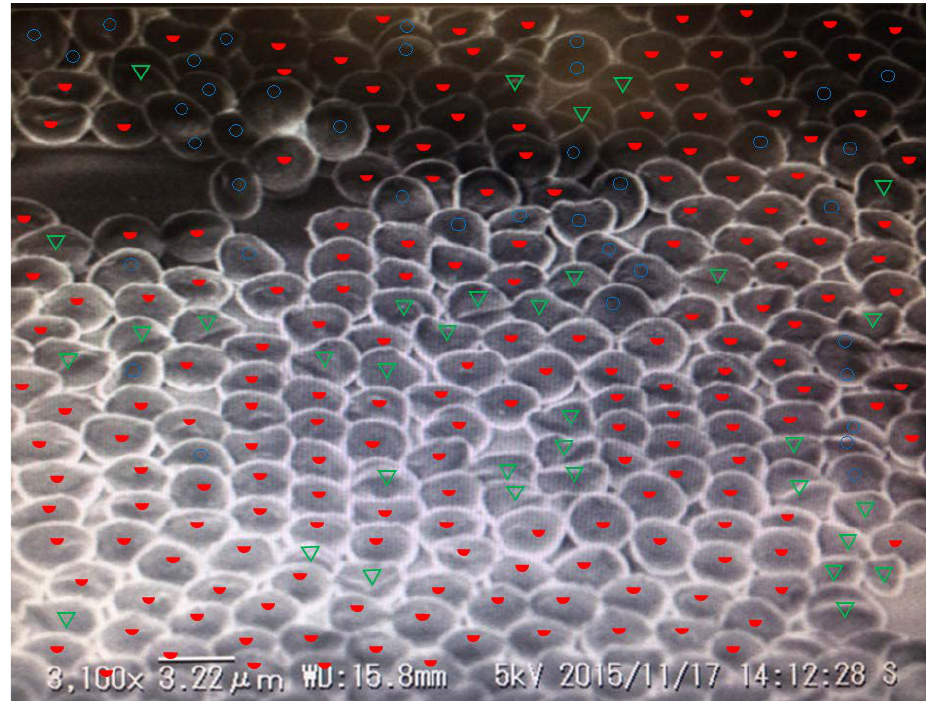
Figure A1. Typical SEM image of particles arranged on a glass slide. The particles marked by the red semicircle (193 particles) are well oriented with the equatorial plane upwards. Those marked by the blue circle (39 particles) are not well oriented or accumulated with the equatorial plane not facing upward. The particles marked by the green triangle (33 particles) do not have a semi-spherical shape. (Referred in Section 2.1.1).